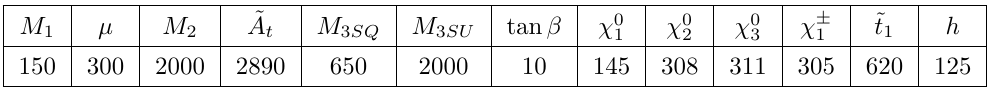
Table 1 . Mass parameters and mass spectrum of SUSY particles for one benchmark point. All masses are in units of GeV.